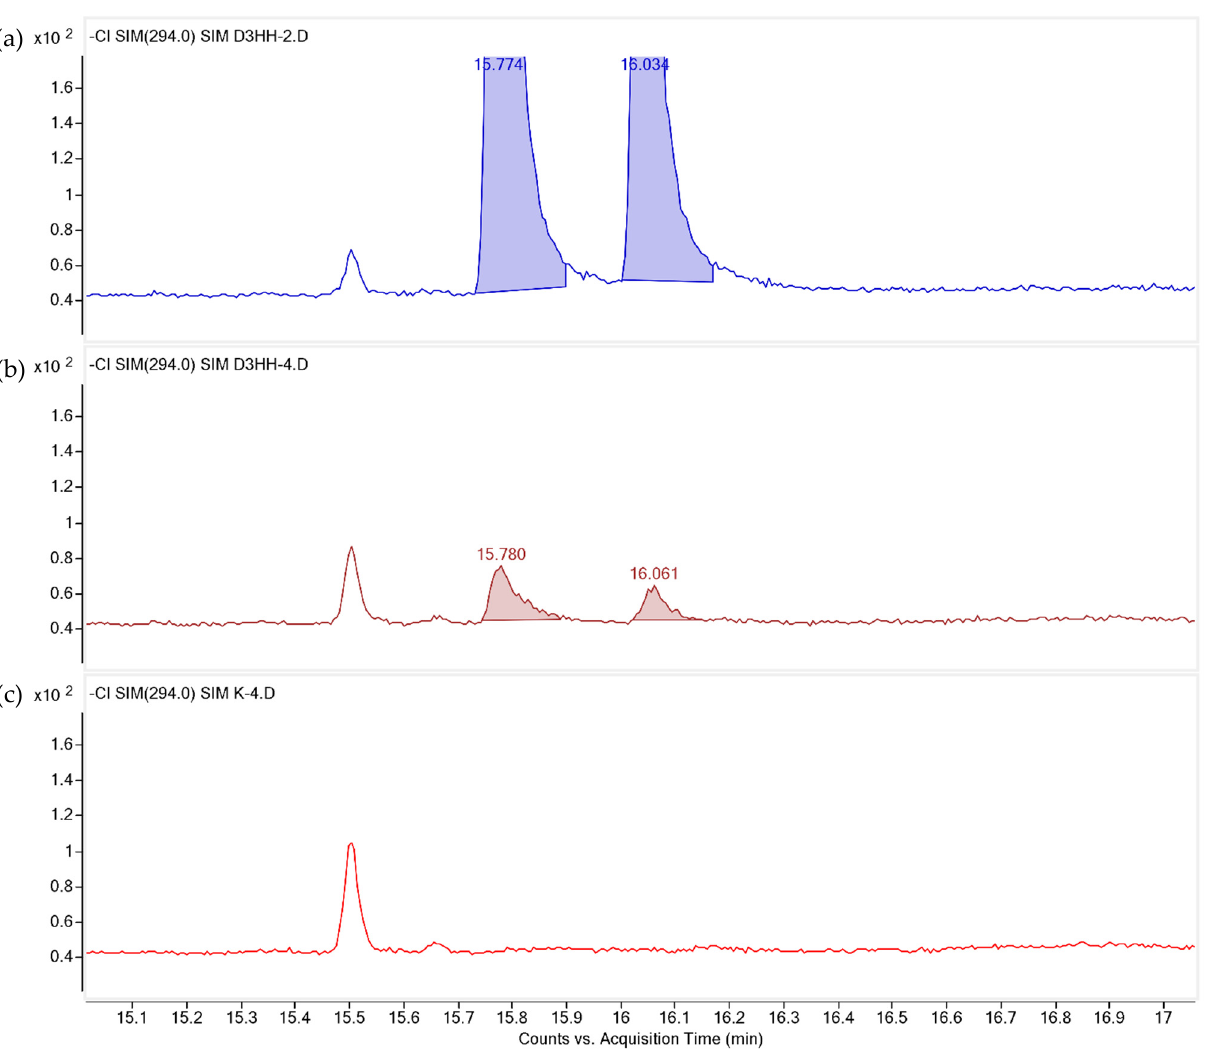
Figure 11. Identification of SIM ( m / z 294) traces of syn- (15.774 min) and anti- (16.061 min) isomers of PFB-silyl-ether derivatives of deuterated HHE. The HT29 cells were cultured in growth medium (Ctrl) without HHE and growth medium with 40 µM deuterated HHE (n = 4) for 0.5 h. ( a ) Deuterated quantification HHE standard; ( b ) cells cultured in 140 µM deuterated HHE; and ( c ) cells cultured in growth medium without HHE.